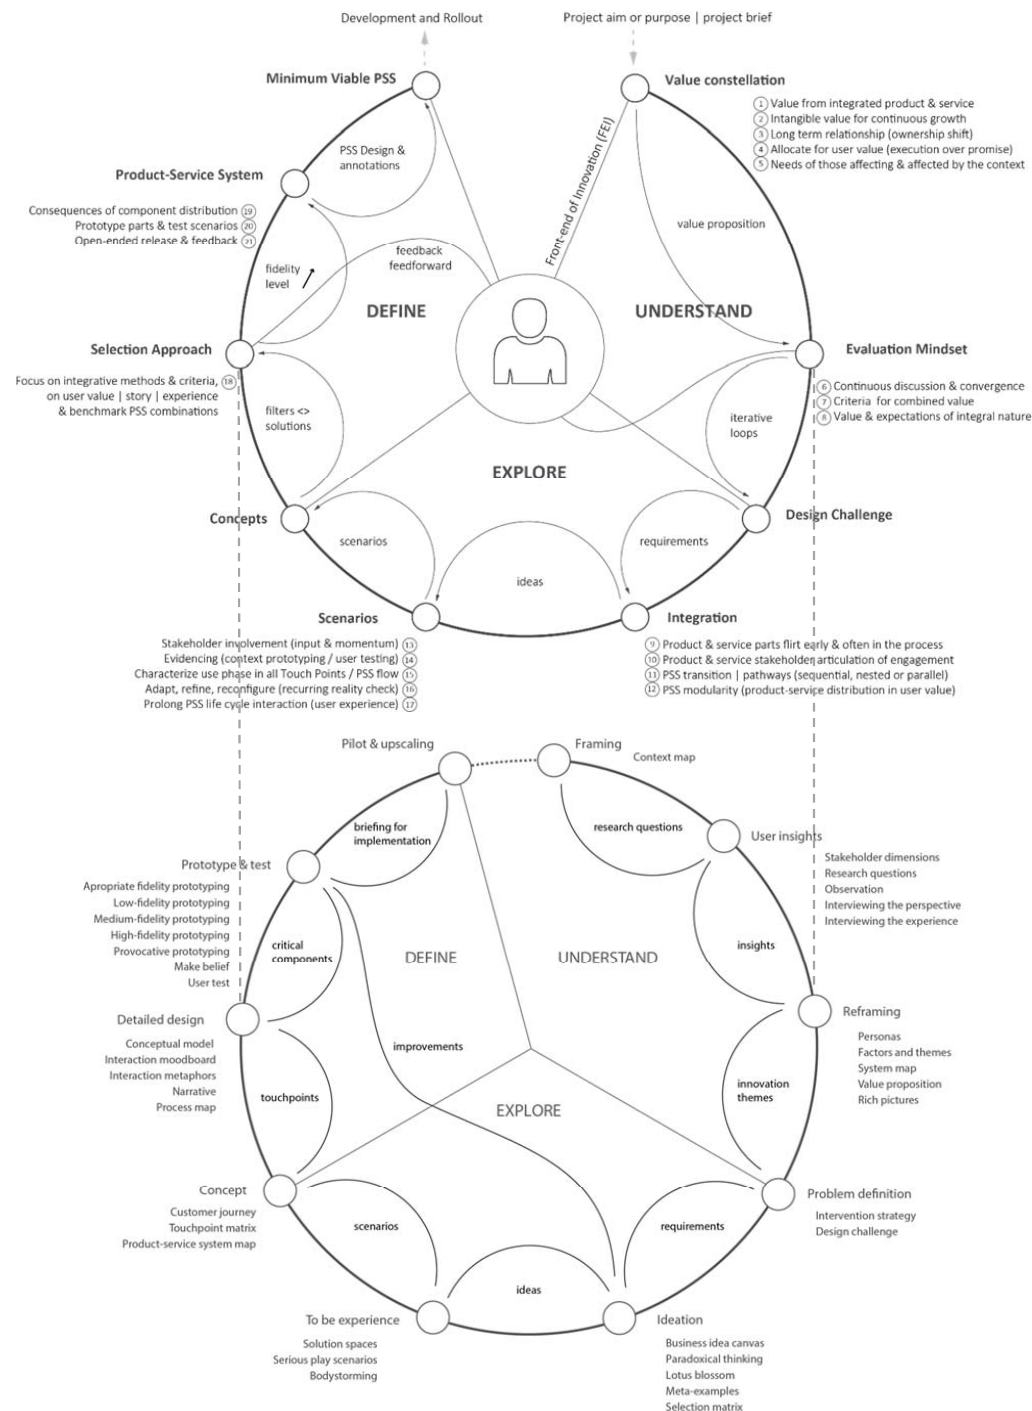
Figure 7. PSS design framework.